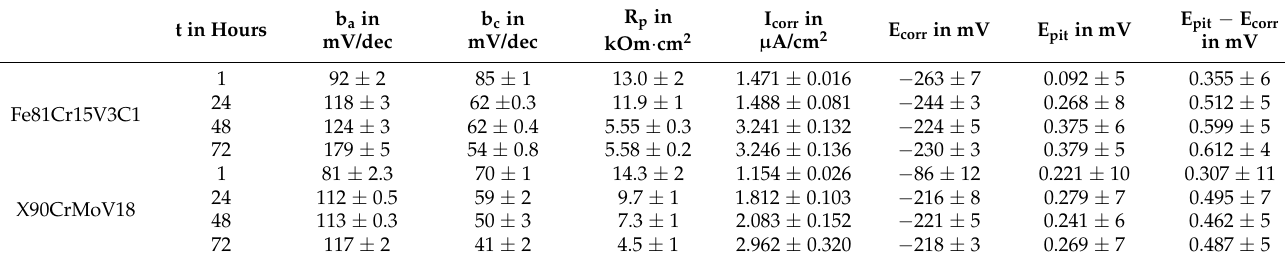
Table 4. Summary of electrochemical corrosion data (mean values of repeated tests) for Fe81Cr15V3C1 and X90CrMoV18 extracted from polarization curves recorded after different im- mersion times (t) at OCP, exemplified as shown in Figure 8: (corrosion potential (E corr ), corrosion current density (I corr ), anodic Tafel slope (b a ), cathodic Tafel slope (b c ), polarization resistance (R p ), pitting potential (E pit ), and passive region (E pit -E corr )).